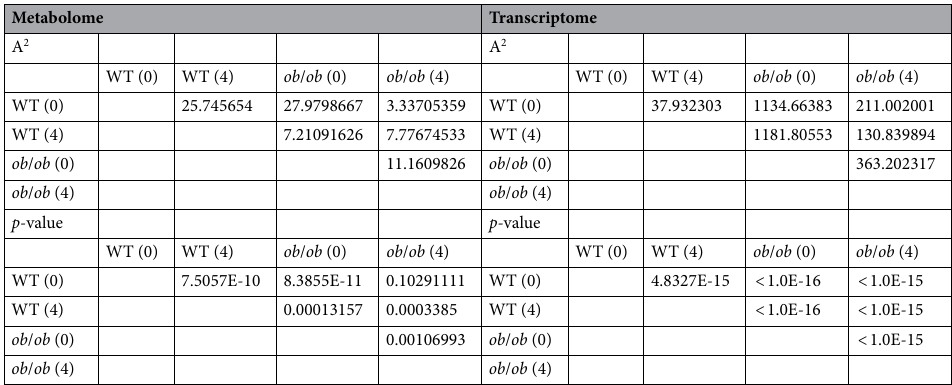
Table 2. The distance of A 2 statistics and p -values. The left and right column represent the metabolome and transcriptome, respectively. The upper and lower table are the A 2 statistics and Bonferroni corrected p -values. In both the tables, WT (0), WT (4), ob / ob (0), and ob / ob (4) stands for WT OGTT (0), WT OGTT (4), ob / ob OGTT (0), and ob / ob OGTT (4),